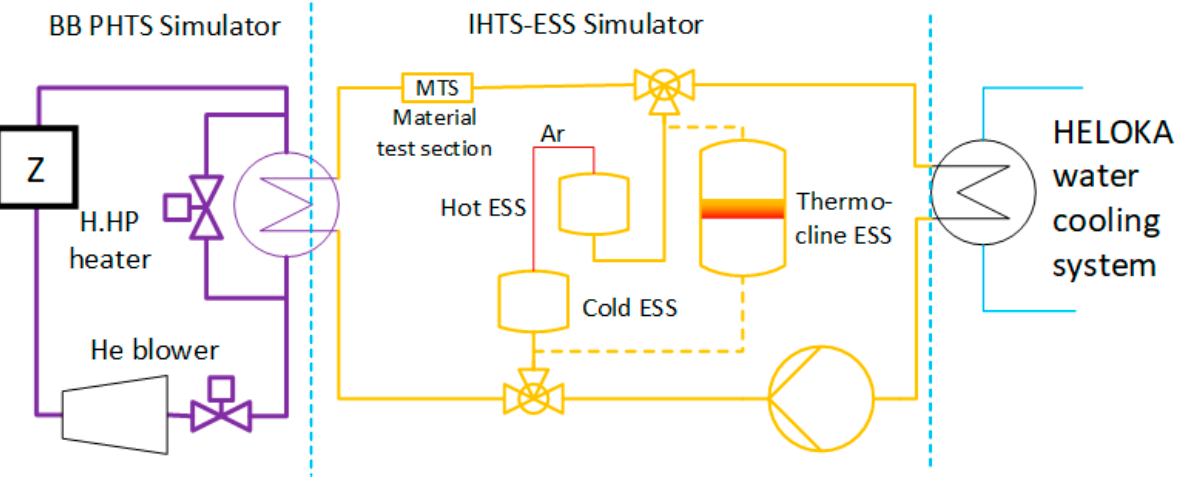
Figure 7. Configuration of HELOKA-US Phase 2 indicating the three systems: PHTS–IHTS/ESS–PCS (only cooling).